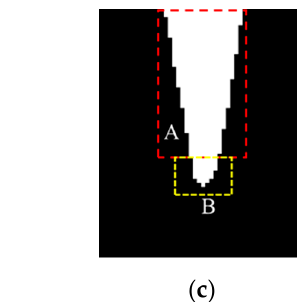
Figure 10. Formation of rectangle